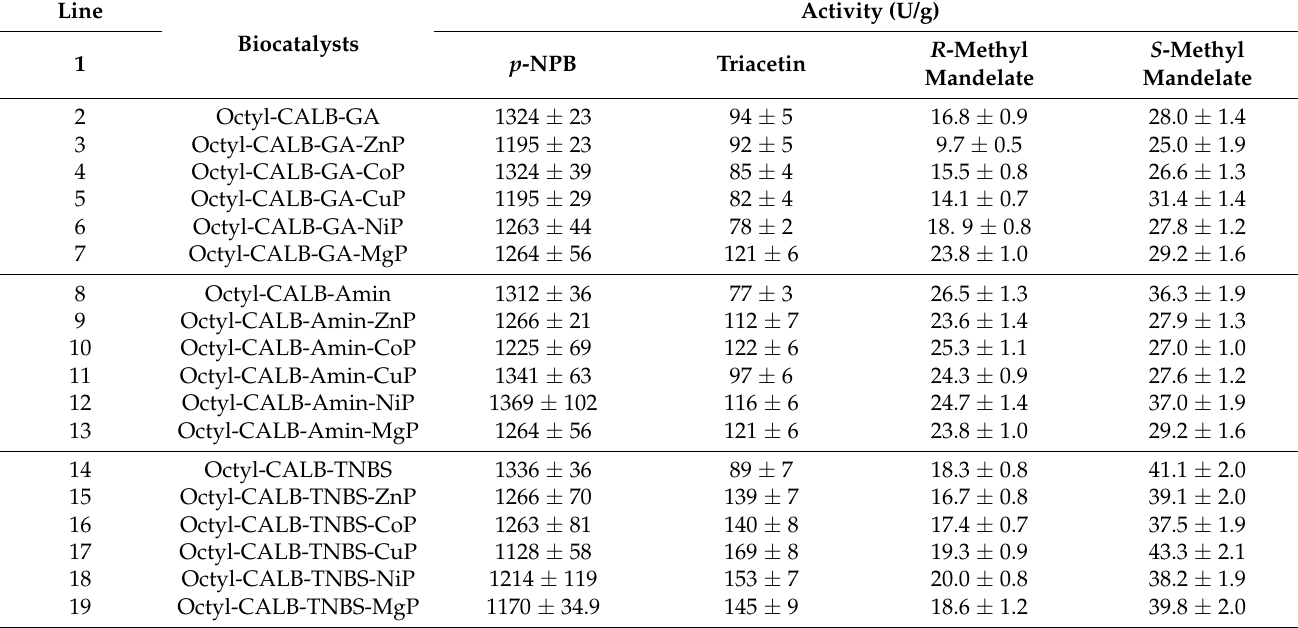
Table 7. Specific activity of different immobilized and chemically modified CALB biocatalysts after solid-phase mineralization. The hydrolytic activity was measured using 1 mM p -NPB (pH 7 and 25 ◦ C), 50 mM triacetin (pH 7 and 25 ◦ C), and 50 mM R - or S -methyl mandelate (pH 7 and 25 ◦